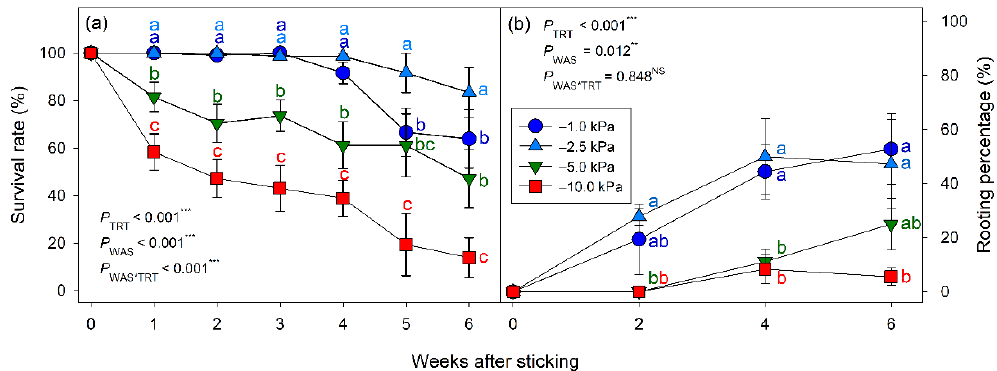
Figure 3. Survival and rooting of English lavender ( Lavandula angustifolia ) cuttings. ( a ) Survival rate and ( b ) rooting percentage at four irrigation thresholds ( − 1.0, − 2.5, − 5.0, and − 10.0 kPa) for six weeks. Points marked with the same letter are not significantly different according to Duncan’s multiple range test at α ≤ 0.05 (at each week of observation). ** , *** , or NS indicates significance at p ≤ 0.01, 0.001, or not significant, respectively. Error bars indicate standard errors.